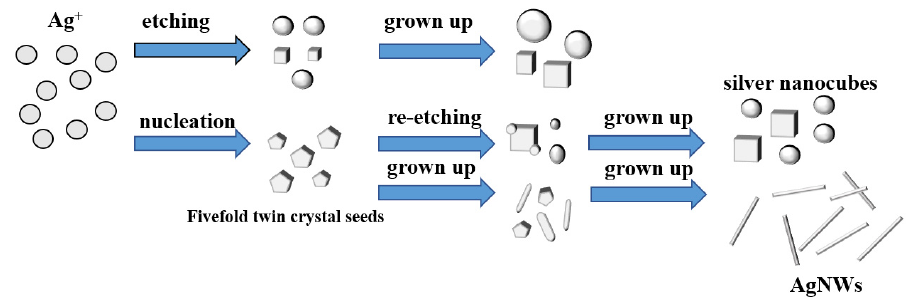
Figure 1. Schematic diagram of the growth mechanism of AgNWs.